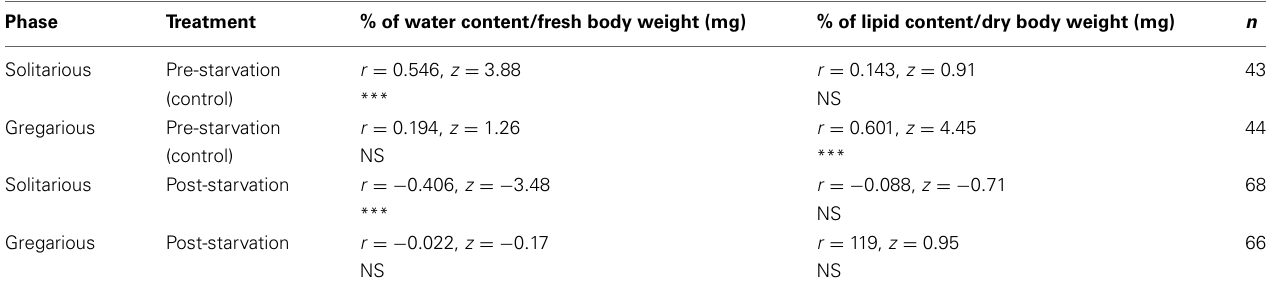
Table 4 | Matrices of statistical correlations (Pearson correlation, r , z -value) between fresh body weight and the ratio of water content/ fresh body weight (%), and between dry body weight and the ratio of lipid content/dry body weight (%) for Schistocerca gregaria hatchlings from either isolated-reared (solitarious) or crowd-reared (gregarious)